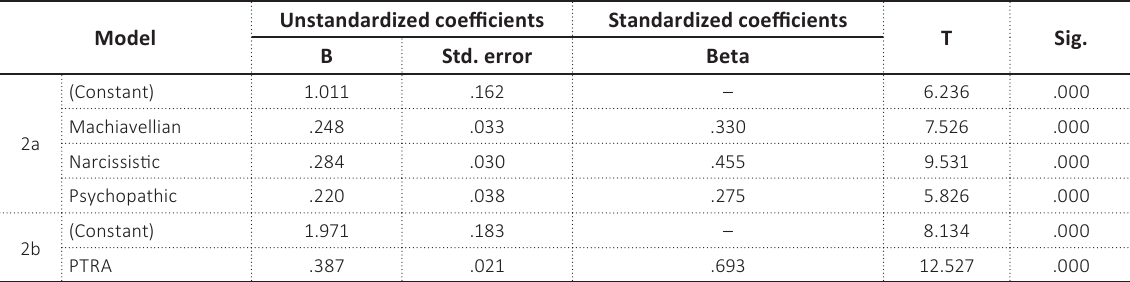
Table 4. Summary of regression